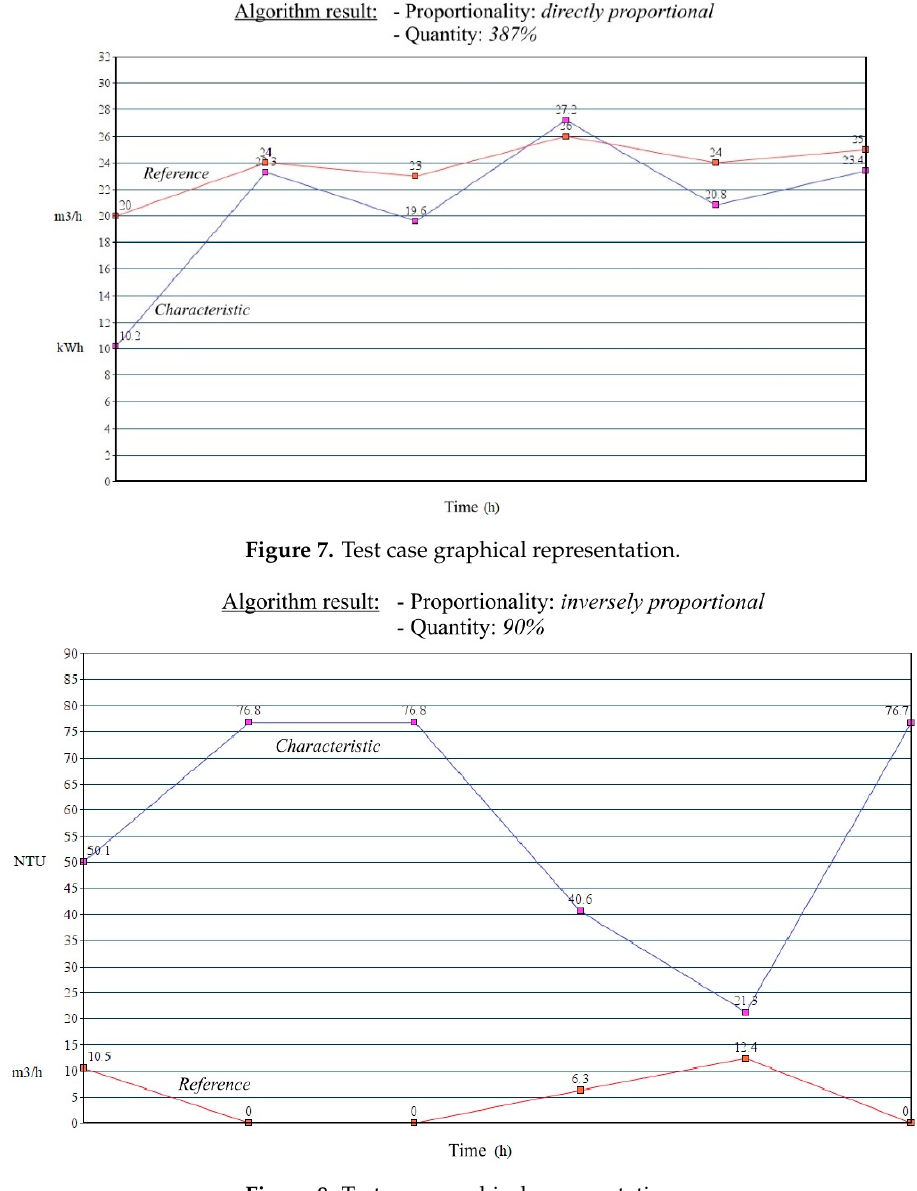
Figure 8. Test case graphical representation.